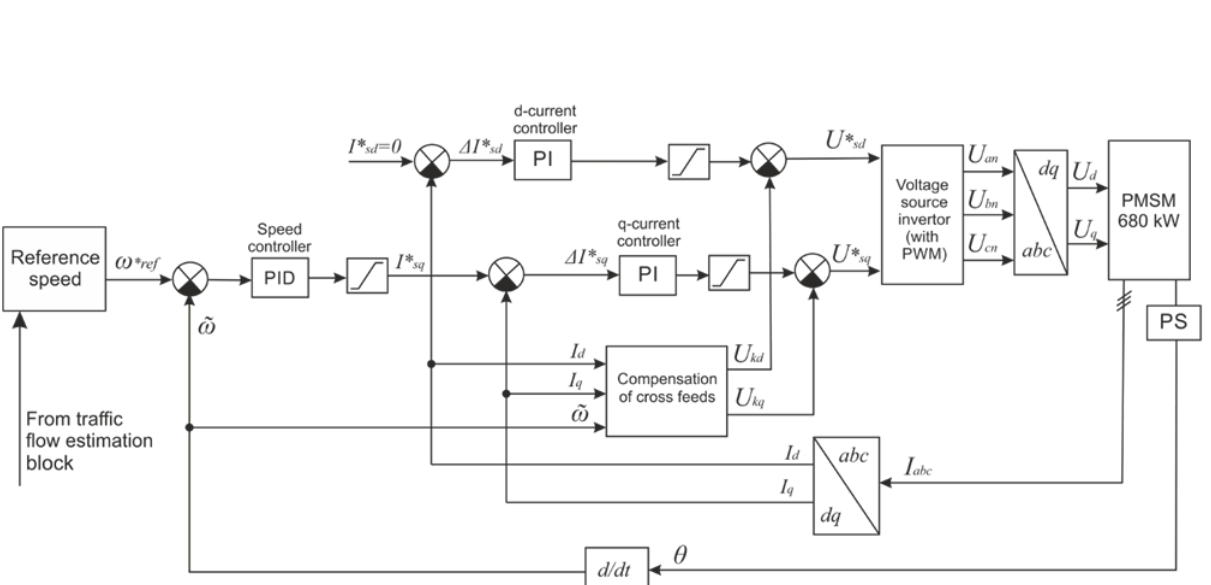
Figure 5 . Design of FOC-PWM control system with i sd = 0 for slow-moving PMSM